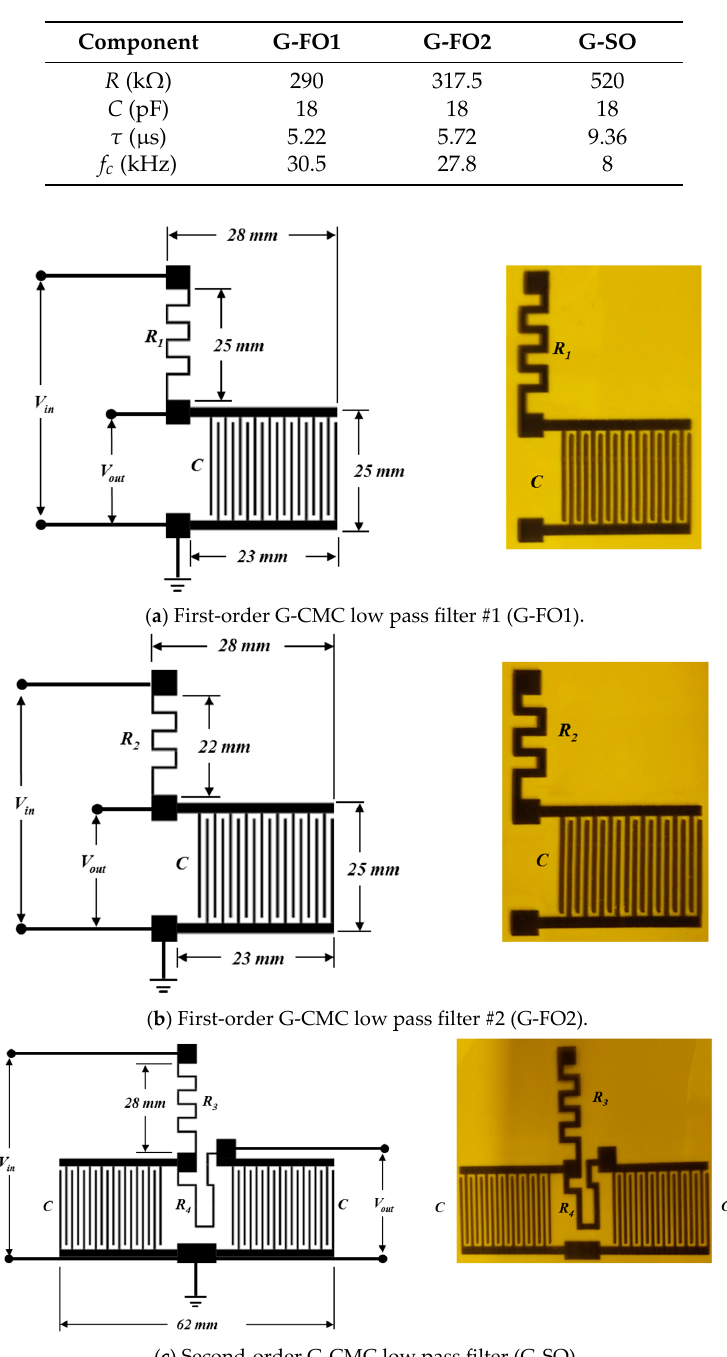
Table 1. Resistance ( R ), capacitance ( C ), time constant ( τ ) and cut-off frequency ( f c ) for printed G-CMC passive filters.